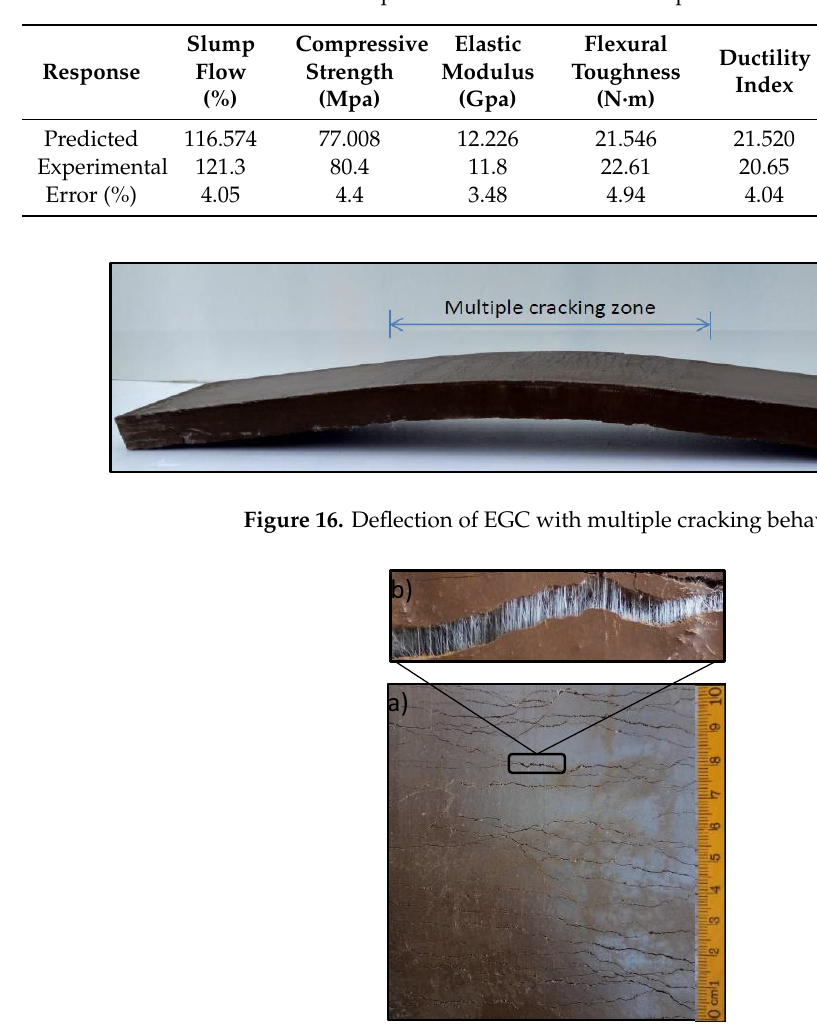
Figure 17. ( a ) Multiple cracking pattern; ( b ) fibers bridging crack opening.